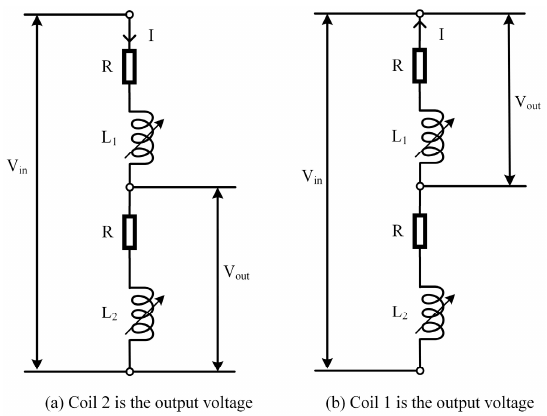
Figure 8. DCSTW excitation